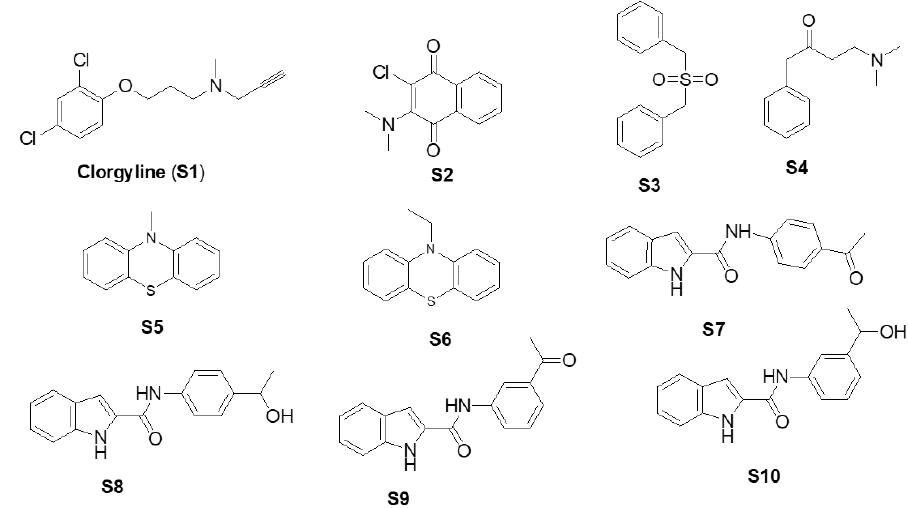
Figure 3. Chemical structures of S1 , S2 – S6 , S7 , and S8 – S10 .